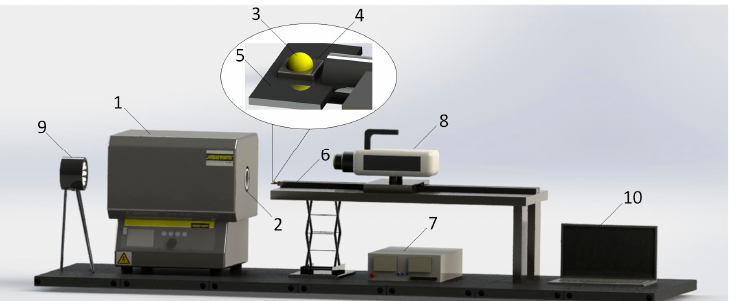
Figure 3. Experimental setup of a mixed heat supply to a fuel droplet. 1—tubular muffle furnace; 2—ceramic tube; 3—fuel droplet; 4—steel; 5—tripod; 6—coordinate mechanism; 7—control unit for coordinate mechanism; 8—high-speed video camera; 9—spotlight; and 10—computer.